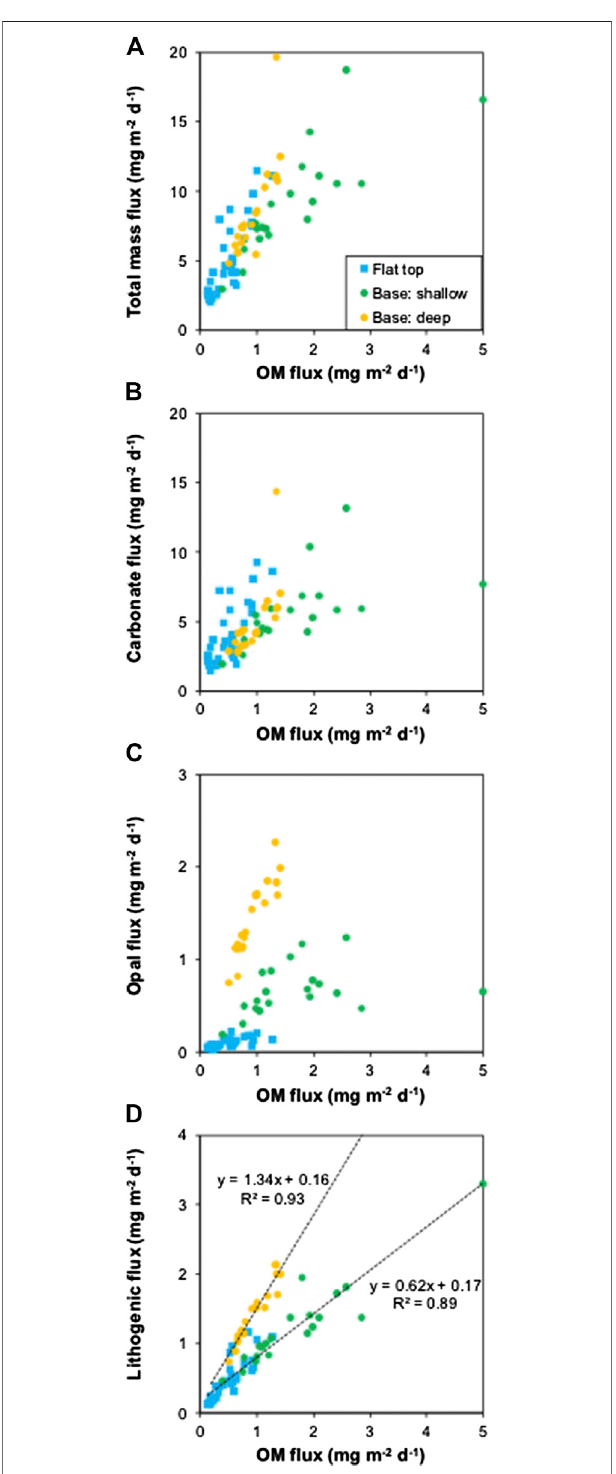
FIGURE 3 | Organic matter (OM) fl ux vs. (A) total mass, (B) carbonate, (C) opal,and (D) lithogenic fl uxes. Dashed lines show regression lines fordata from shallow and deep sediment